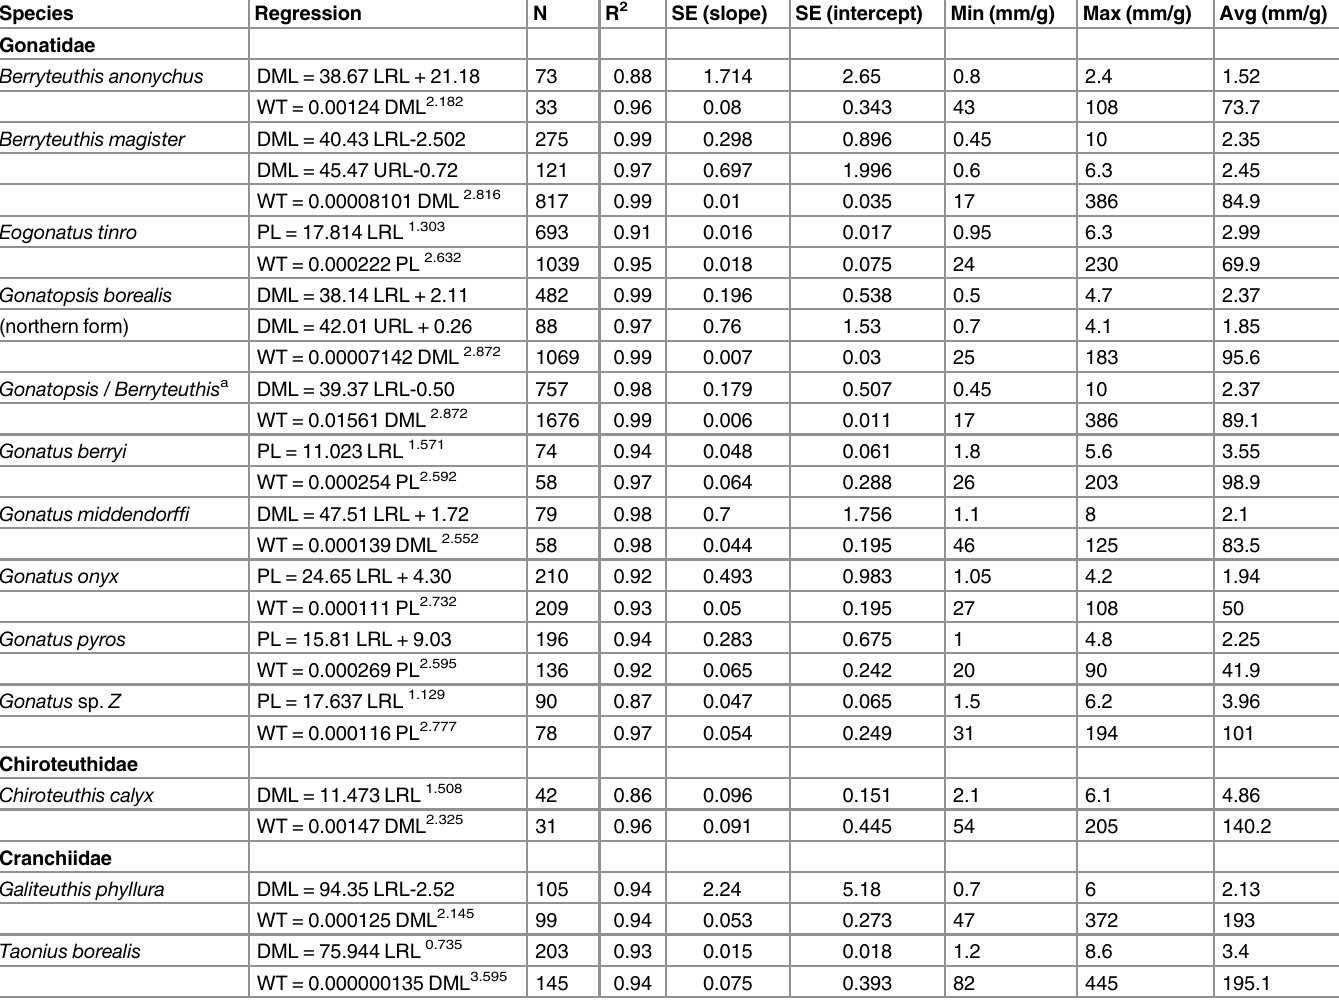
Table 2. Cephalopod length and weight regression equations. Lower beak rostral length (LRL) and upper beak rostral length (URL) were measured (mm) and regressed on dorsal mantle length (DML) or pen length (PL). Dorsal mantle length or PL was regressed on weight (WT)